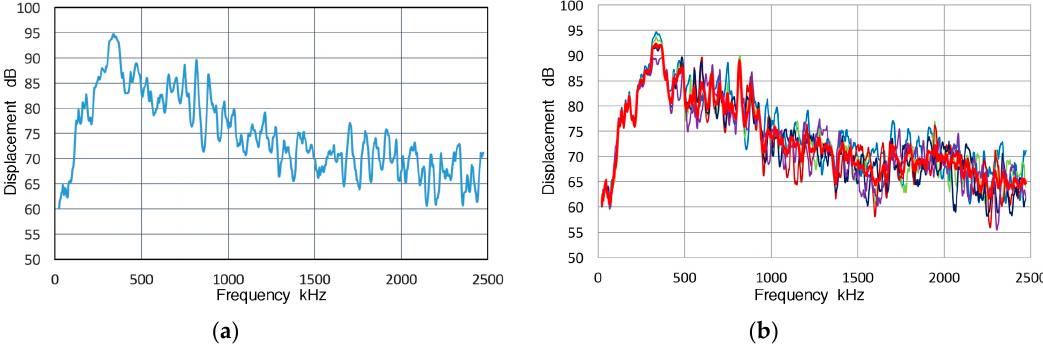
Figure 3. ( a ) FFT magnitude spectrum of normal displacement at L = 300 mm at the center; ( b ) FFT magnitude spectra of normal displacement at L = 300 mm: Center-blue curve, 1 mm off-center-light green, 2 mm off-center-dark red, 3 mm off-center-dark blue, 5 mm off-center-purple, Average of five curves-red.